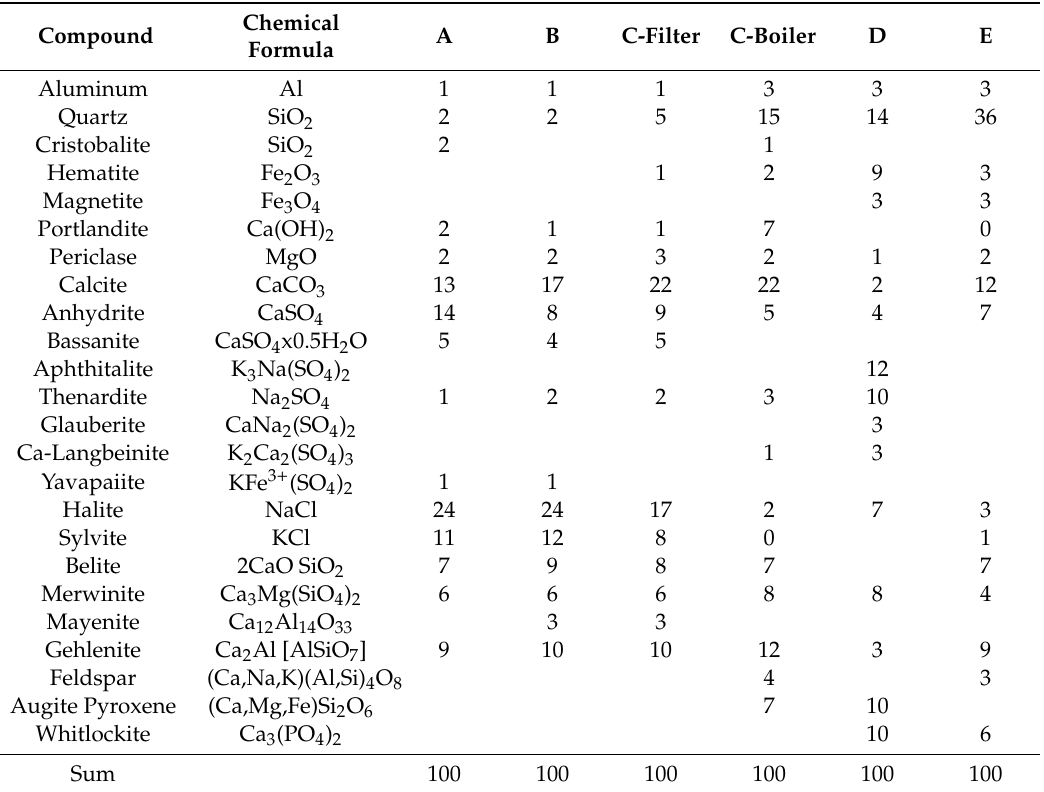
Table 5. XRD-Rietveld refinement results of six compounds (given in wt % and normalized to 100%). Amorphous contents and unidentified minor components are probably present but could not be accounted for. Therefore, the quantification error is estimated at 20% relative and minimum of 2%